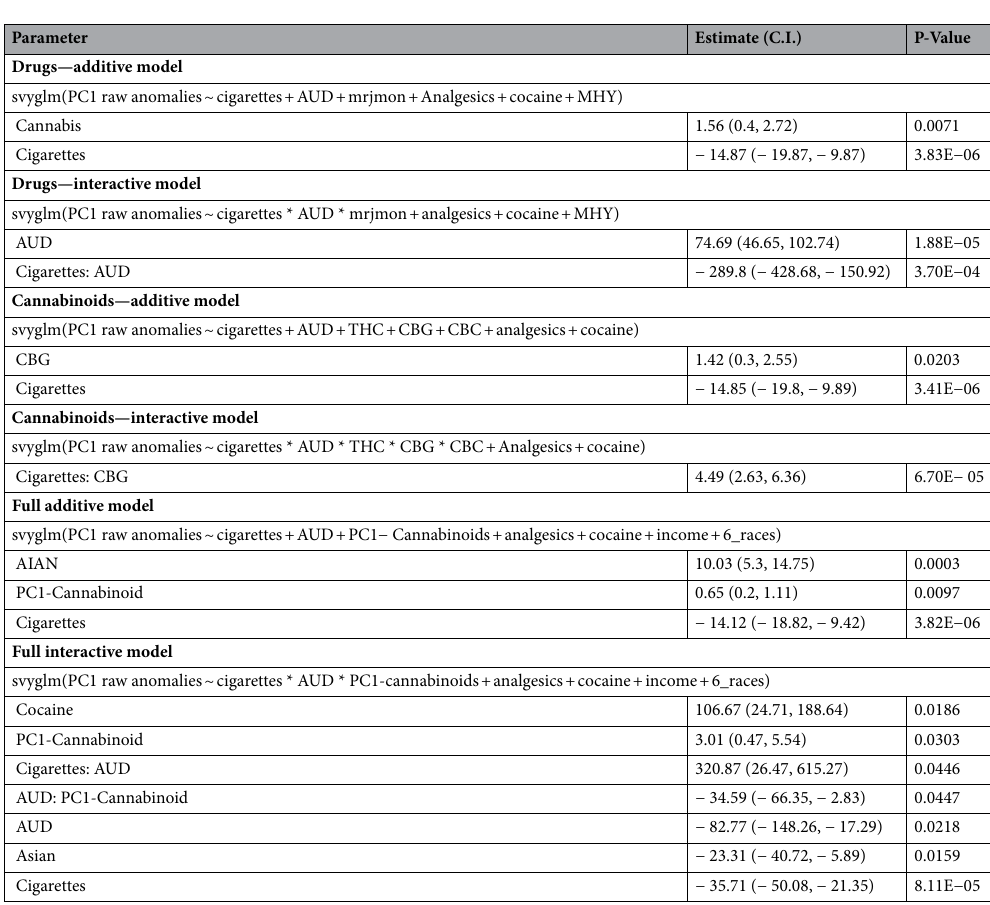
Table 2. Robust IPW-weighted generalized regression analyses on PC1 for raw congenital anomaly data. Final robust generalized linear regression models for CAR Dataset.